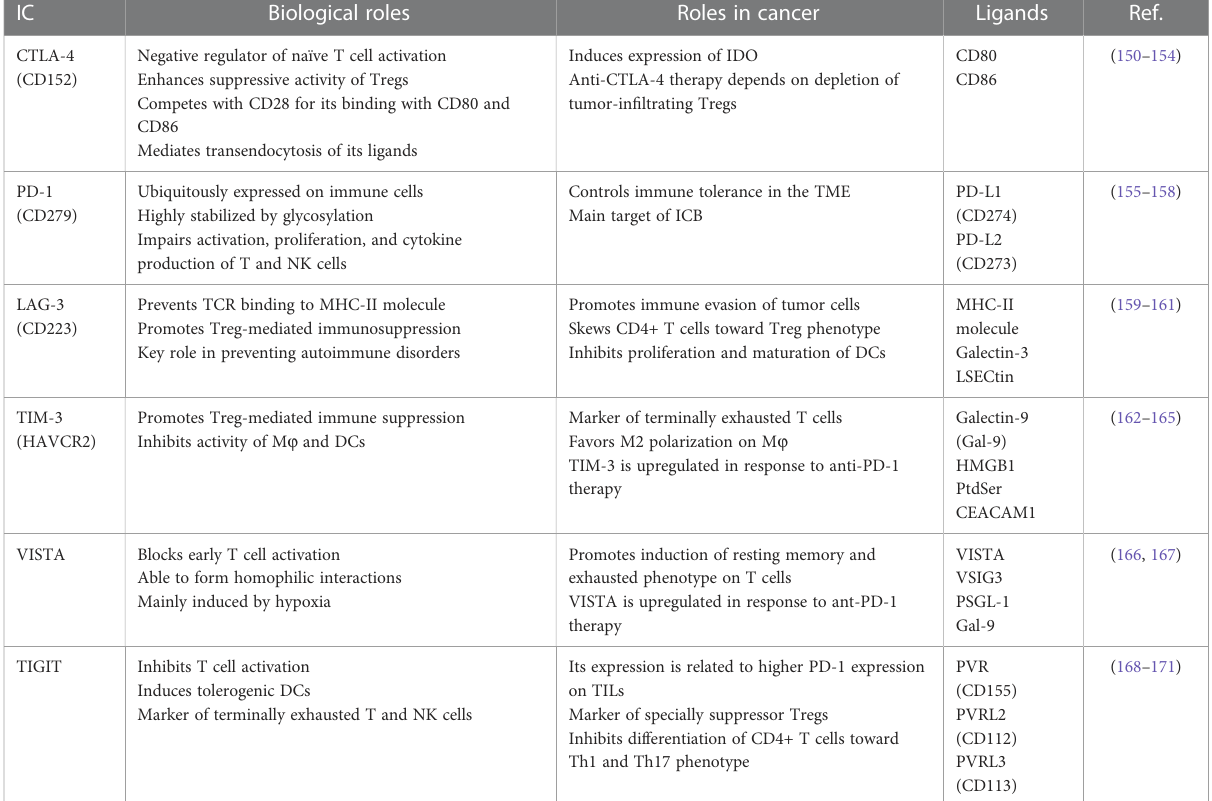
TABLE 2 Main ICs and their ligands expressed in the